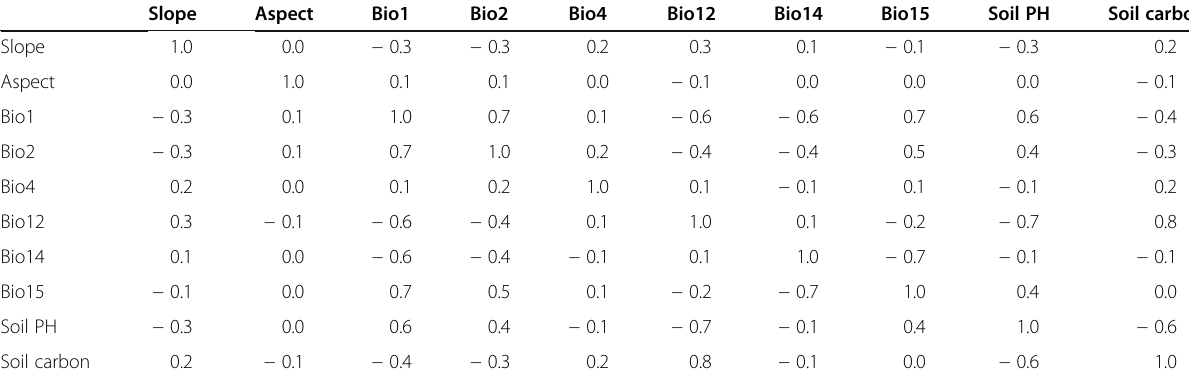
Table 1 Correlation matrix for the variables using in modeling Slope